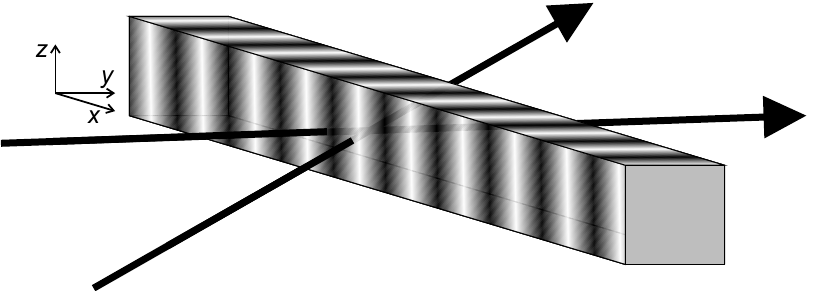
Figure 1. Scheme of the two-wave mixing experiment used for grating